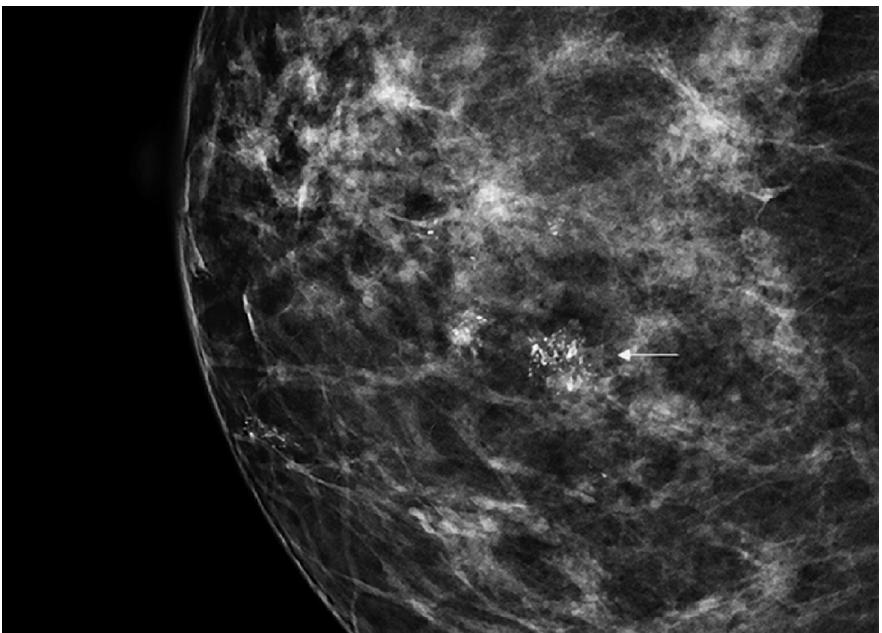
Figure 1. Spot magnification mammogram with a small cluster of pleomorphic microcalcification (arrow) suspicious for ductal carcinoma in situ (DCIS)/ductal intraepithelial neoplasia (DIN).